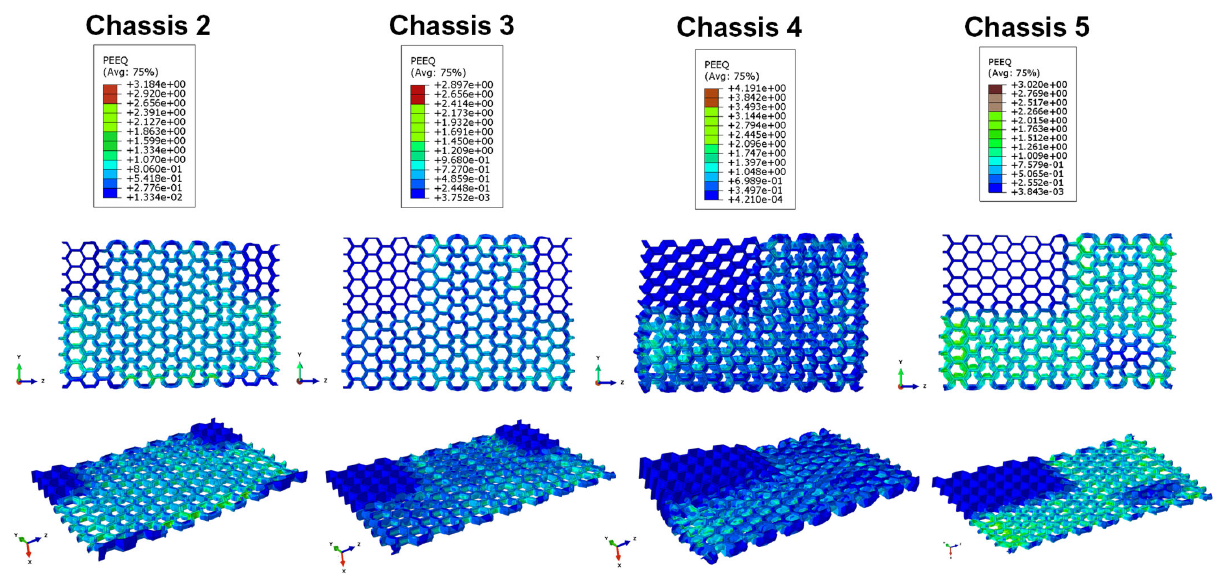
Figure 14. Equivalent Plastic Strain of the shock absorbers’ core.